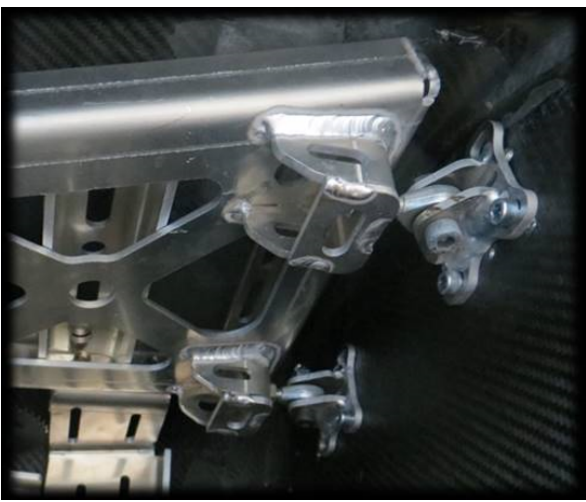
Figure 12: Connection of rear axle to central plate.